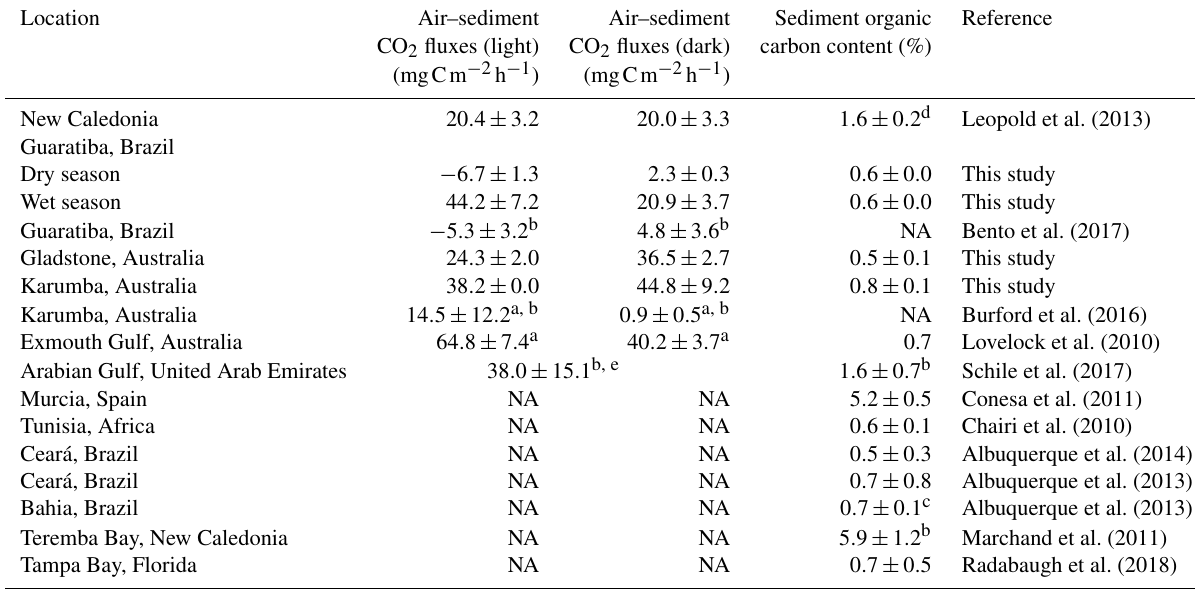
Table 3. Mean sediment organic carbon content (%) and CO 2 fluxes (mgCm − 2 h − 1 ) at the air–sediment interface in hypersaline tidal flat sediments reported in the literature. Values are means ± standard error unless otherwise